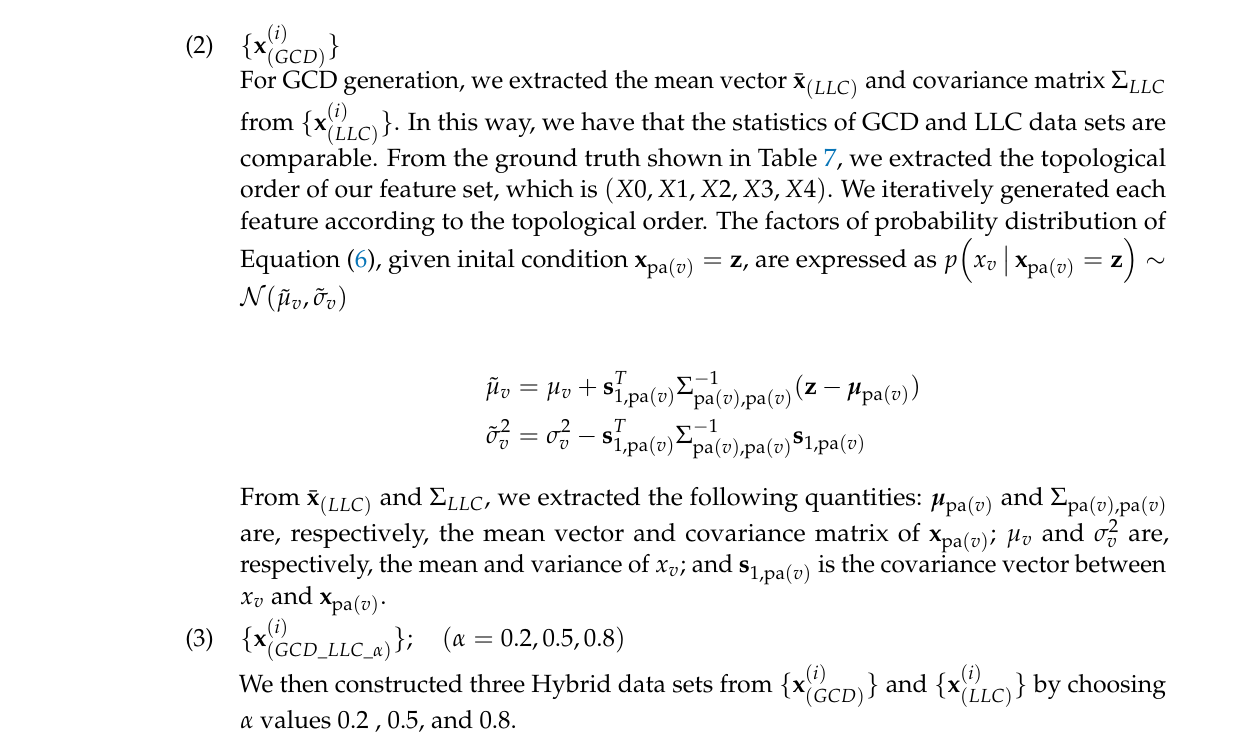
( t − 1 ) ( t − 1 ) ) for generating the m , . . . , x 0 4